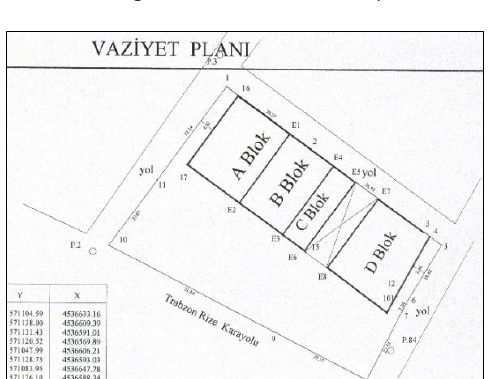
Figure 2. Layout plan